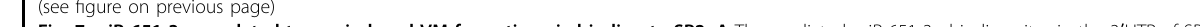
Fig. 7 miR-651-3p regulated tumor-induced VM formation via binding to SP2. A The predicted miR-651-3p binding sites in the 3 ′ UTR of SP2 (SP2-3 ′ UTR-Wt) and the designed mutant sequence (SP2-3 ′ UTR-Mut) were indicated. Luciferase reporter assay of HEK-293T cells co-transfected with SP2-3 ′ UTR-Wt or the SP2-3 ′ UTR-Mut and the indicated miRNA. Data are presented as the mean ± SD ( n = 3, each group). * P < 0.05 vs. pre-NC + SP2-3 ′ UTR-Wt group. B Expression levels of SP2 regulated by miR-651-3p in U87 and U251 cells. Data are presented as the mean ± SD ( n = 3, each group). * P < 0.05, ** P < 0.01 vs. pre-NC group; # P < 0.05 vs. anti-NC group. C The expression of SP2 in U87 and U251 cells after co-transfection with linc00707 and miR-651-3p plasmid was shown. Data are presented as the mean ± SD ( n = 3, each group). * P < 0.05 vs. linc00707( − )-NC + pre-NC group. D – F CCK-8 assay, transwell, and three-dimensional culture were applied to evaluate the proliferation, migration, invasion, and tube formation effect of miR-651-3p and SP2. The scale bar represents 50 µm. G The expression of VM formation-related proteins in U87 and U251 cells after co-transfection with miR-651-3p and SP2 plasmid was shown. Data are presented as the mean ± SD ( n = 3, each group). * P < 0.05,** P < 0.01 vs. pre-NC + SP2( + )-NC